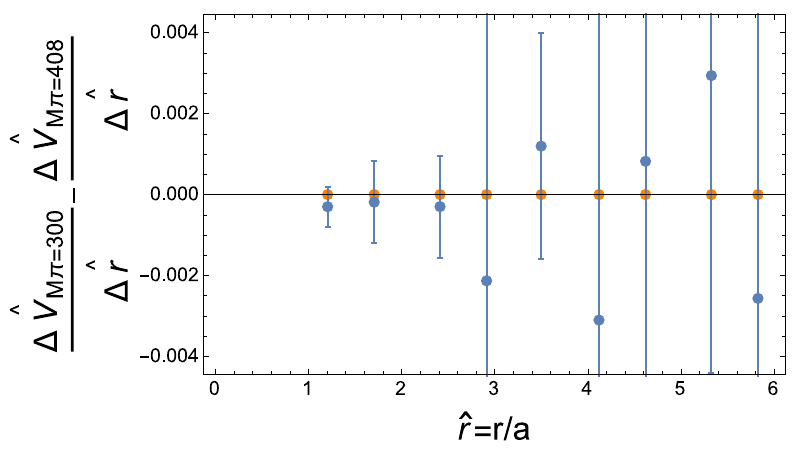
Figure 17 . Di(cid:11)erence of the (approximate) slopes of the potentials in the di(cid:11)erent pion masses ( M (cid:25) = 300 MeV and 408 MeV). The potential V and distance r are normalized by lattice spac- ing a . The blue data show the lattice results with statistical errors. The orange points are the perturbative estimate.